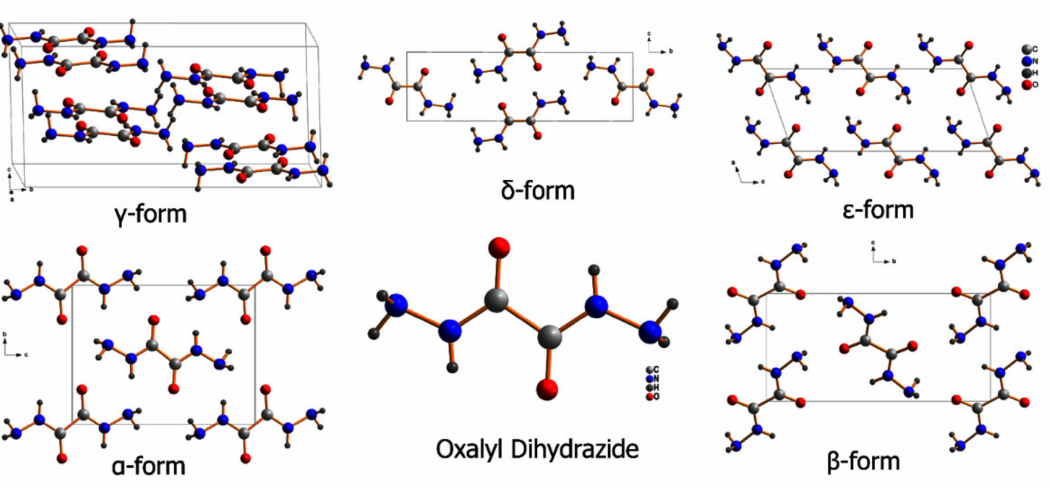
Figure 6. Crystal structures of ODH polymorphic forms: α , β , δ , γ , and ε forms. Reprinted with permission from Ref. [82]. Copyright 2015 American Chemical